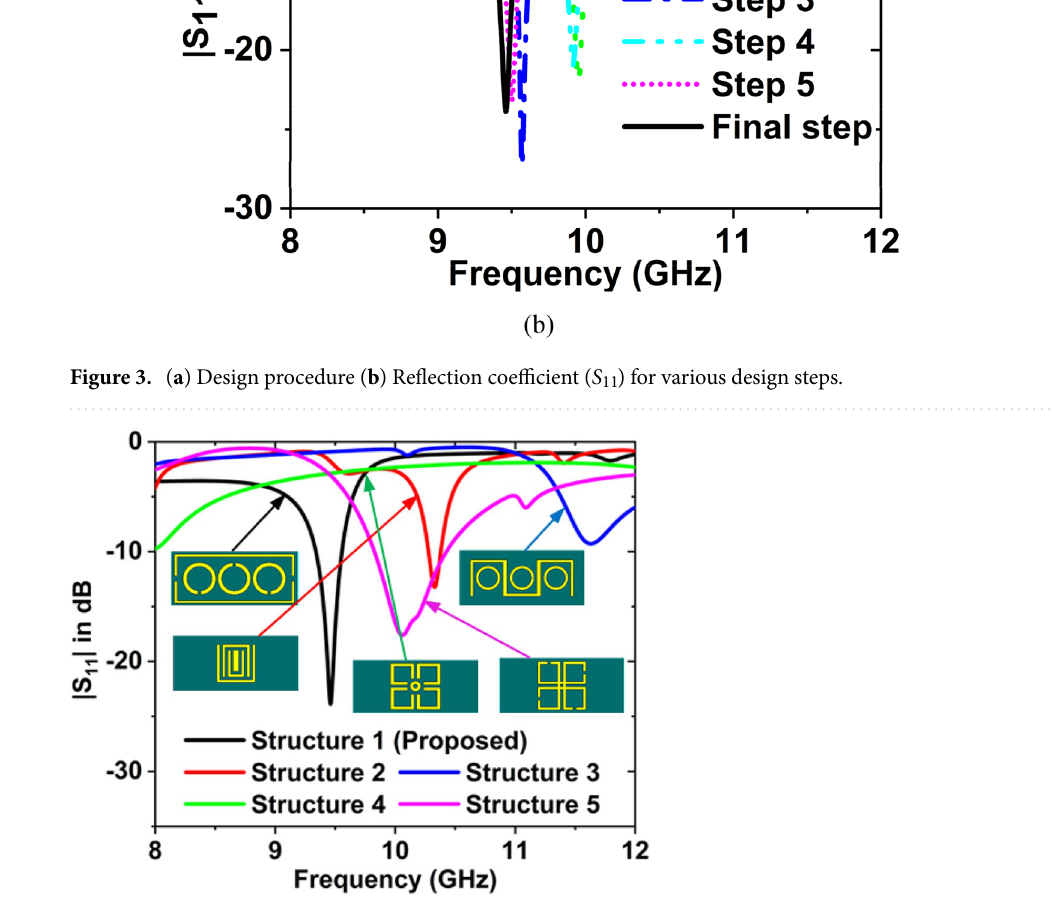
Figure 4. Frequency versus S 11 graph for the different resonator